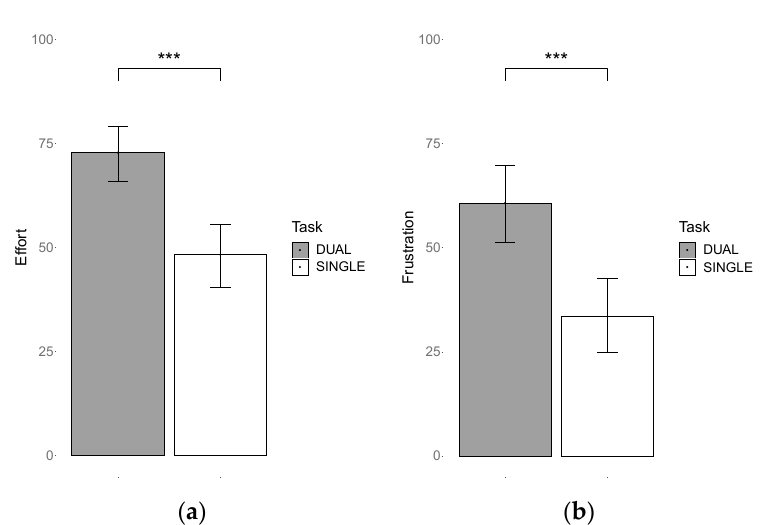
( b ) Figure 11. ( a ) Mean perceived mental demand and ( b ) perceived performance as a function of task difficulty. *** p < 0.001. Furthermore, participants reported a higher perceived performance (N = 25, W = 36, p < 0.001, r